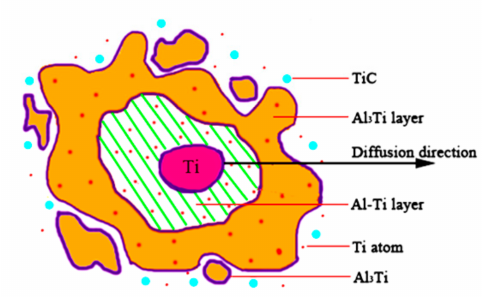
Figure 13. The lace structure model of the Al-5Ti-0.62C system.